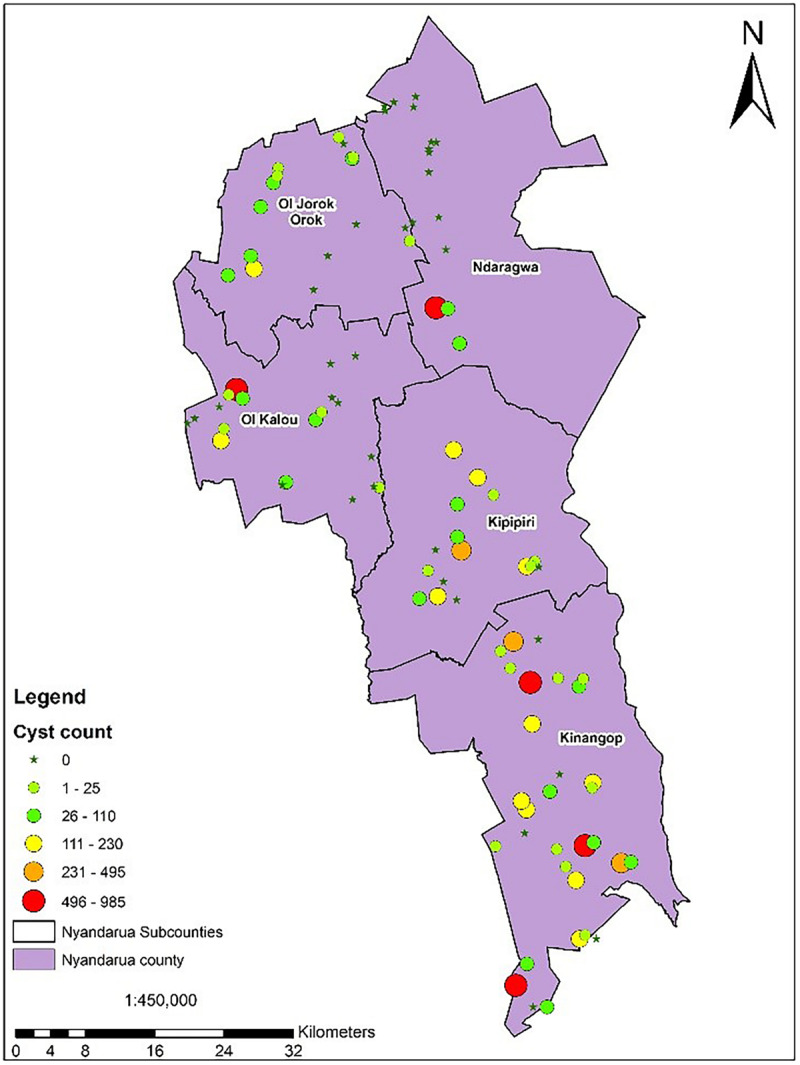
PCN infestation levels across the 5 sub-counties of Nyandarua indicating the “hot-spots” in red.